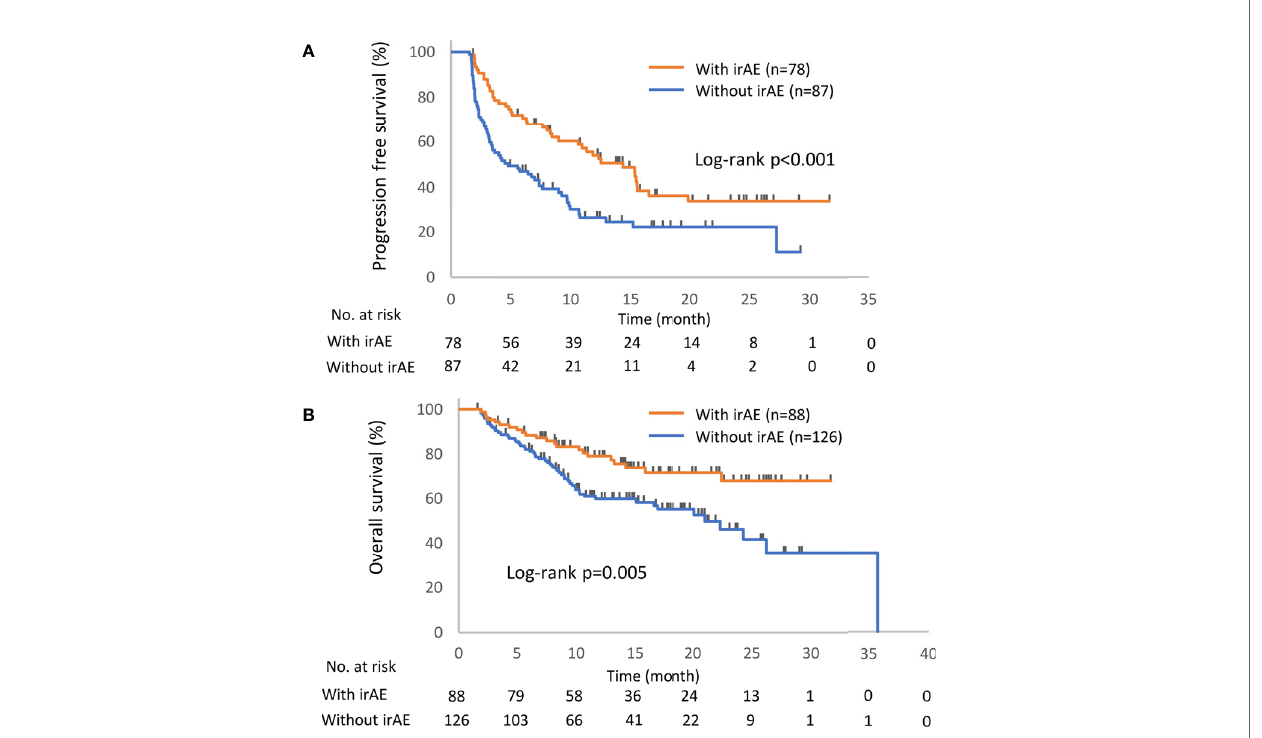
FIGURE 2 | Kaplan – Meier curves for the 6-week landmark analysis of the progression-free survival (A) and overall survival (B) of patients with or without irAEs. IrAE, immune-related adverse event.